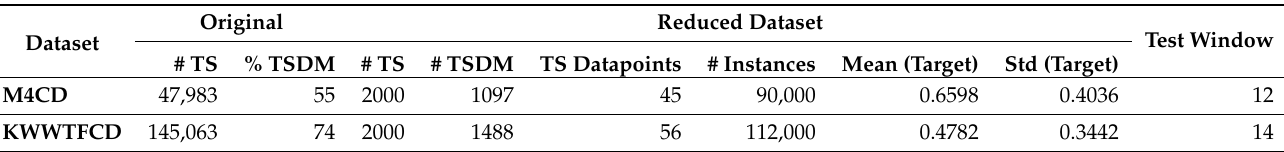
Table 1. Descriptive data for the M4CD and KWWTFCD datasets. TSDM is used as an abbreviation for time series with values of different orders of magnitude, while TS abbreviates time series.